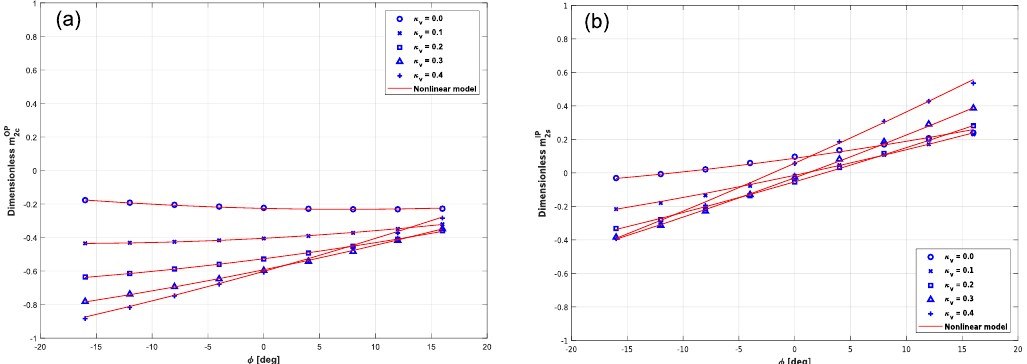
Figure 4. Comparison between measured and predicted harmonics for the nonlinear model of order 2 (solid thin lines). Normalized out-of- plane 2 Rev cosine (a) and in-plane 2 Rev sine (b) are shown for different wind state × ×